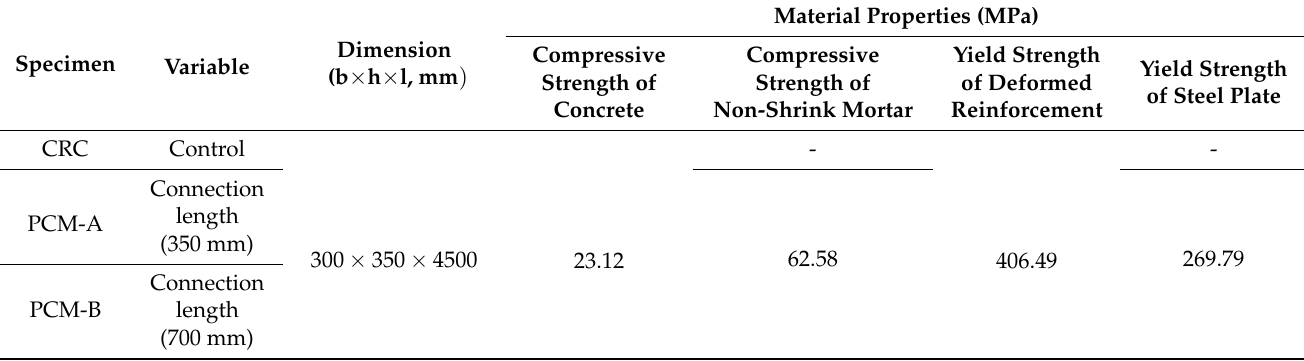
Figure 6. Stress–strain curve: ( a ) concrete; ( b ) non-shrink mortar; ( c ) deformed reinforcement; ( d ) steel plate. Table 1. Details of specimens.